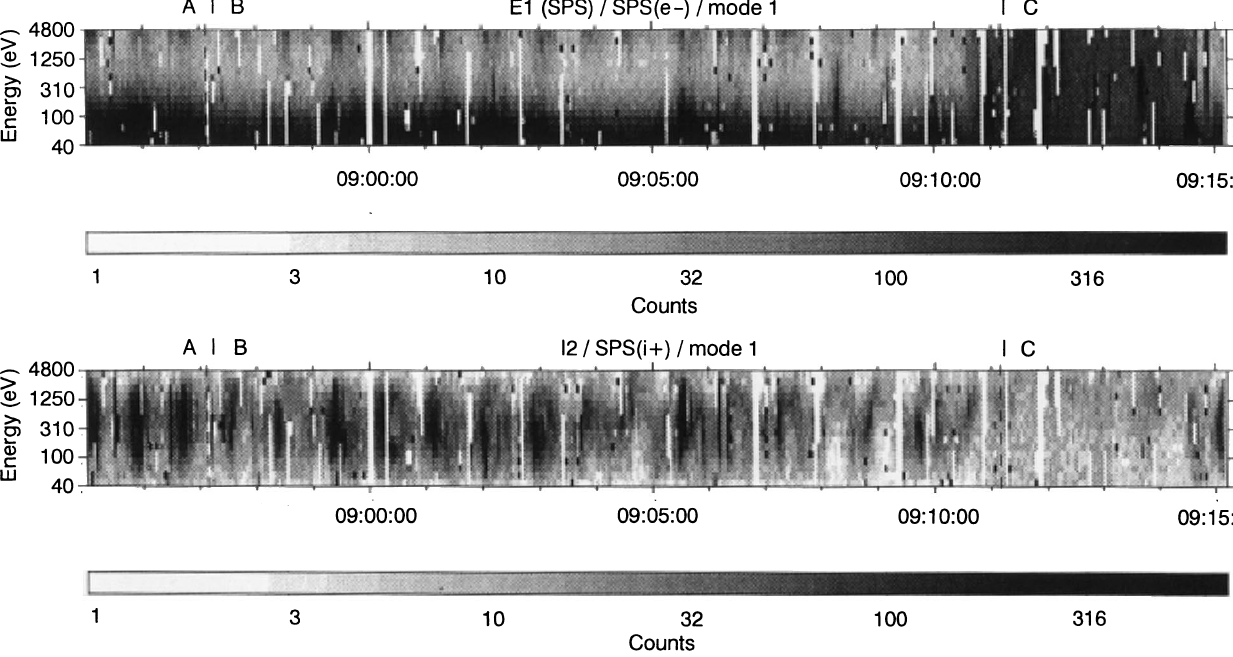
Fig. 6. Ion-and electron-energy dynamic spectrograms of the magnetopause crossing observed on 29 August by the MAGION–4 satellite. From all channels of the SPS device only those with